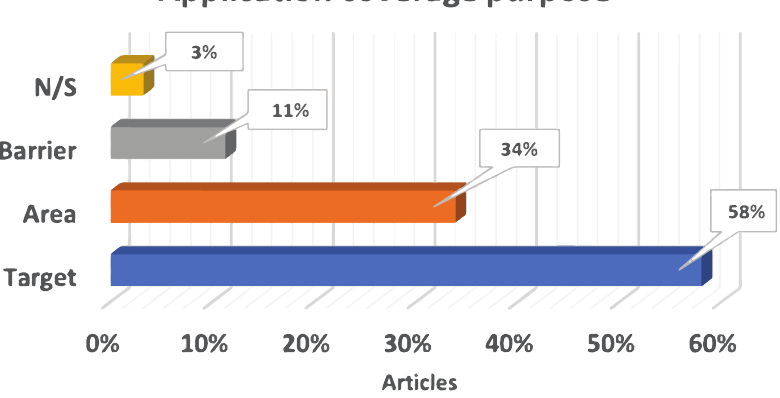
Figure 9. Percentage distribution of articles according to the application monitoring